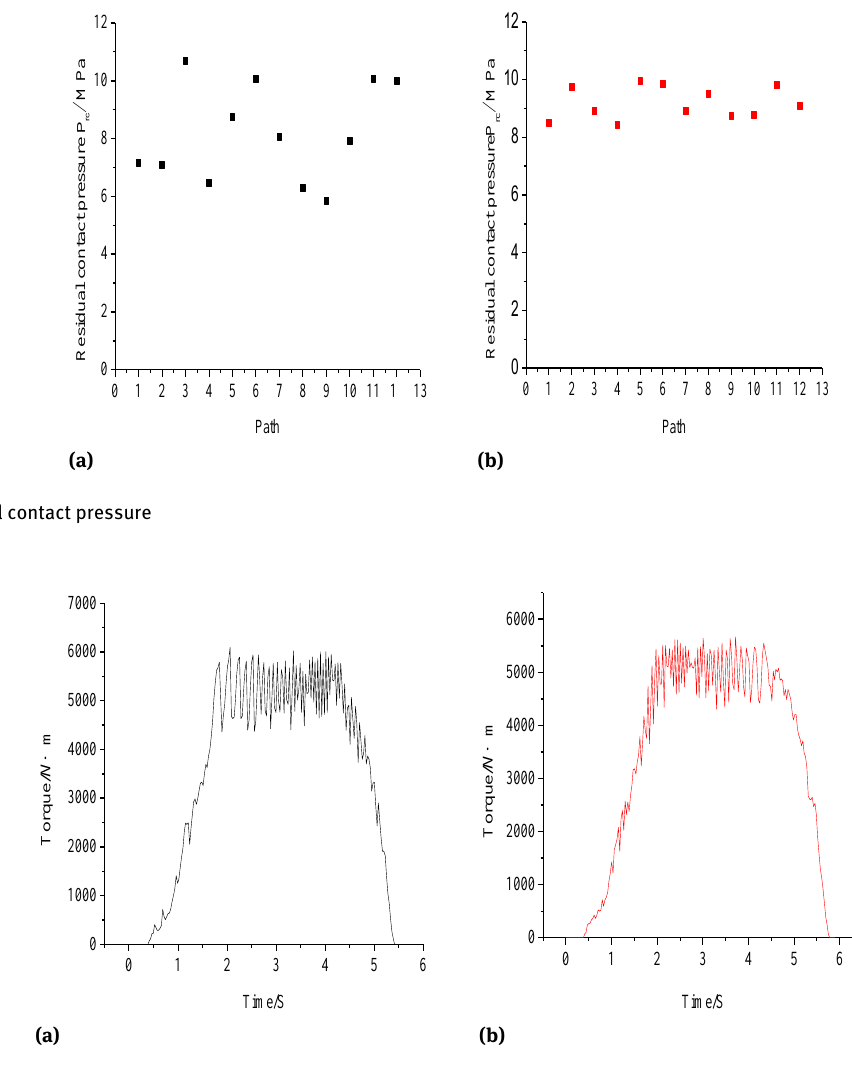
Figure 6: Torque